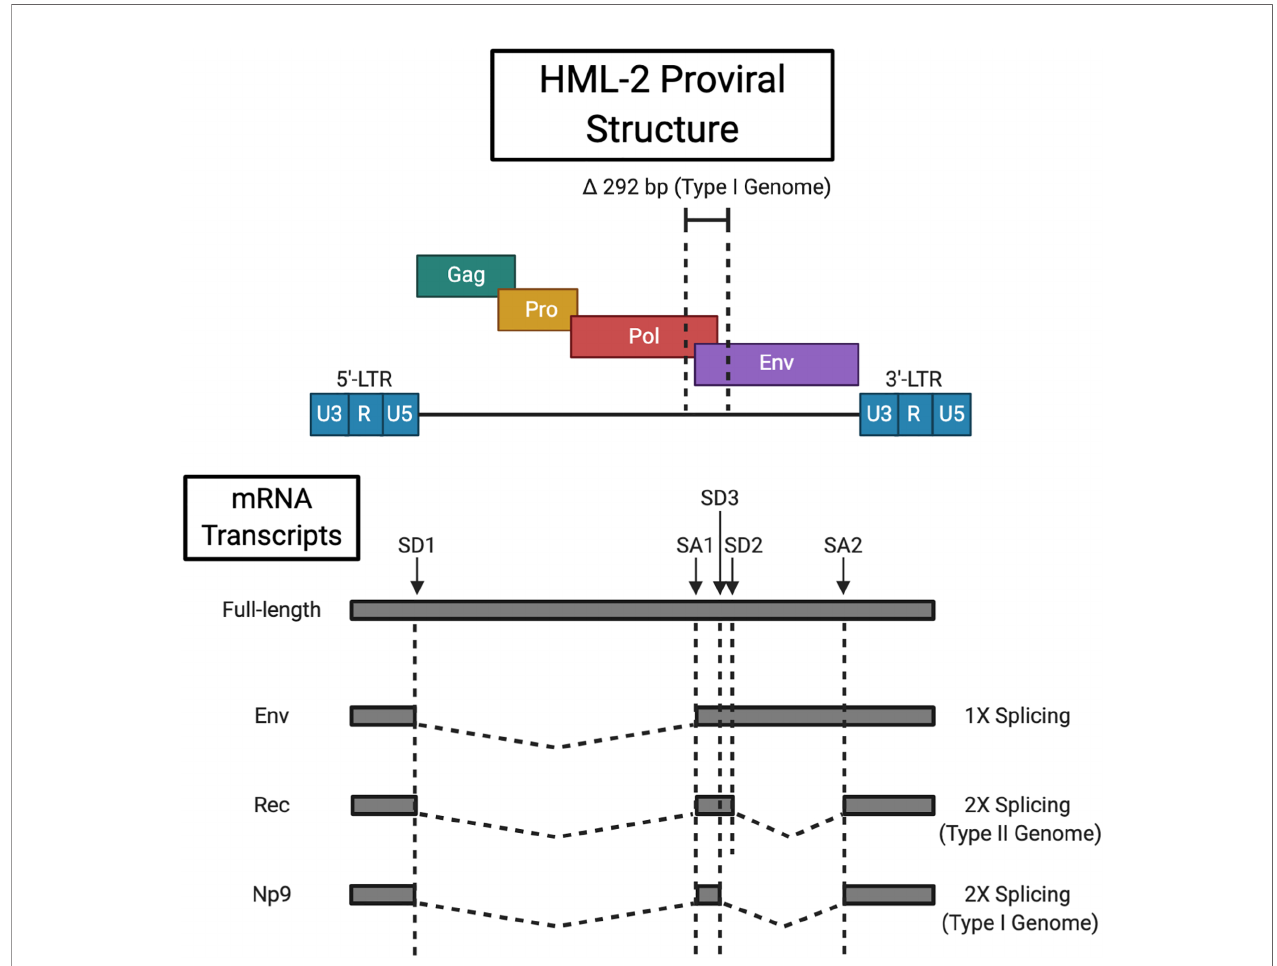
FIGURE 1 | HML-2 Proviral Structure. HML-2 proviral integrations have either a type I or type II genome delineated by the respective presence (type I) or absence (type II) of a 292 bp deletion at the pol/env boundary. The full length transcript codes for the Gag precursor and Gag-Pro/Gag-Pro-Pol fusion proteins that are processed by the viral protease and cellular proteasome respectively. Singly sliced HML-2 mRNA encodes the Env protein, while a secondary slicing event of env mRNA gives rise to the Rec (type II) or Np9 (type I) accessory proteins. Splice donor (SD) and splice acceptor (SA) sites are indicated (type II loci combine SD2 and SA2 for rec splicing while type I loci contain the alternative SD3 site for np9 transcript generation). Created with